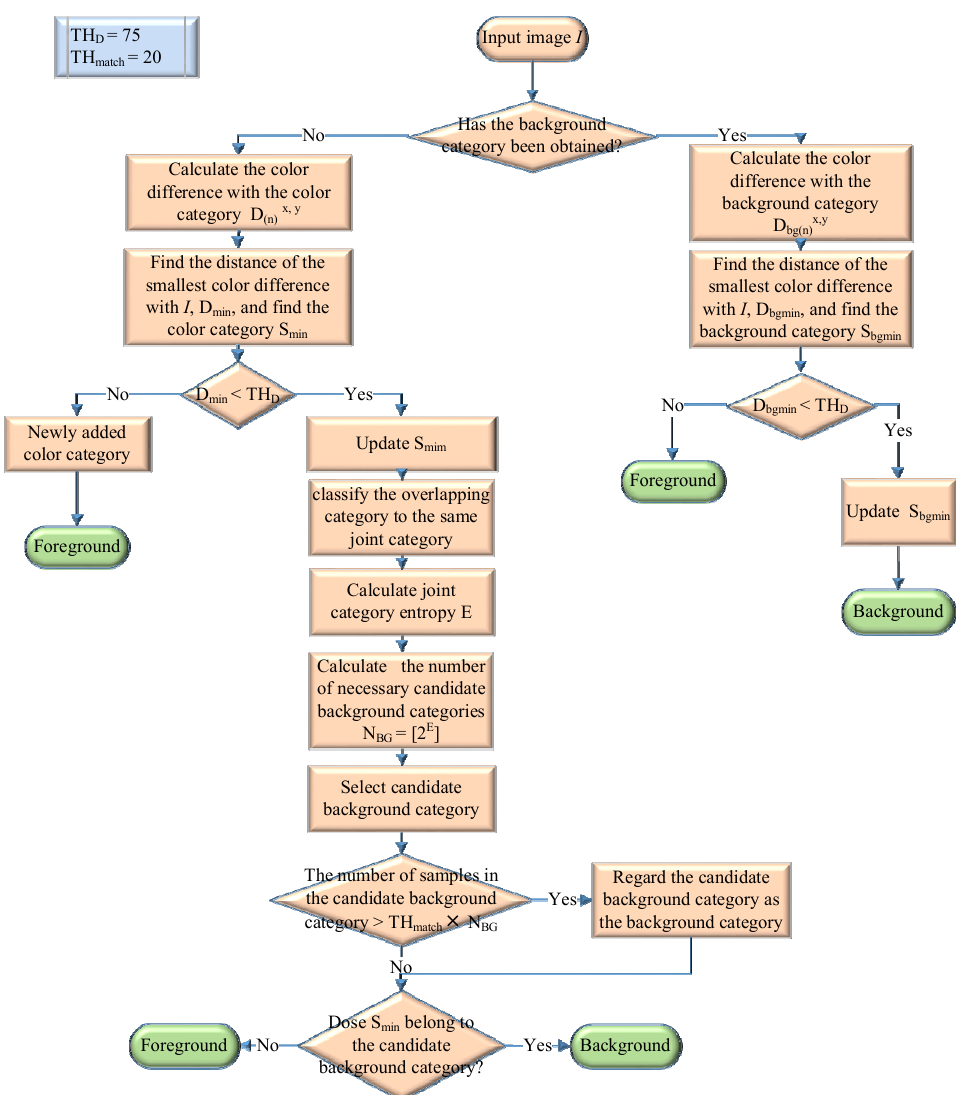
Figure 1. Flowchart of the proposed algorithm.